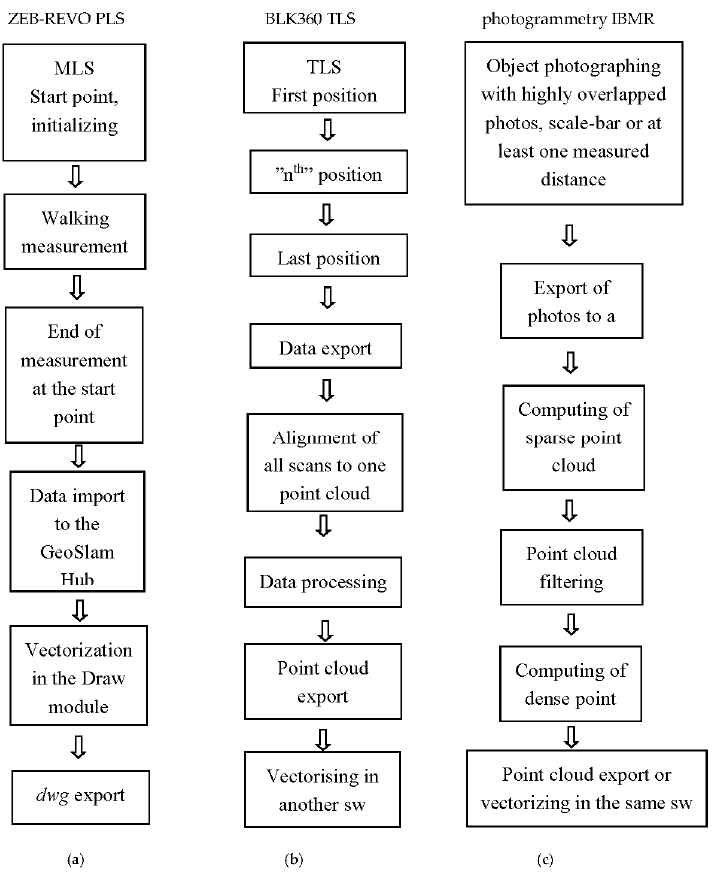
Figure 7. Schematic workflow for ( a ) personal laser scanner (PLS) ZEB-REVO, ( b ) TLS BLK360, and ( c ) for Image-Based Modeling and Rendering (IBMR) photogrammetry.